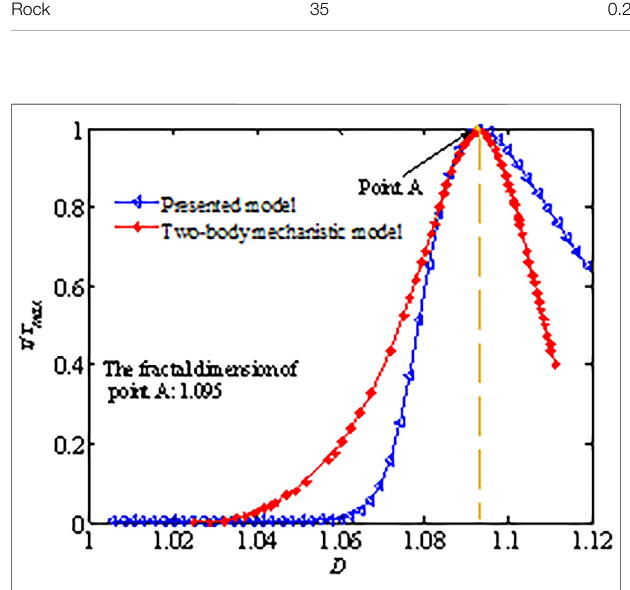
FIGURE 7 | Relationship between the shear strength and the fractal dimension D